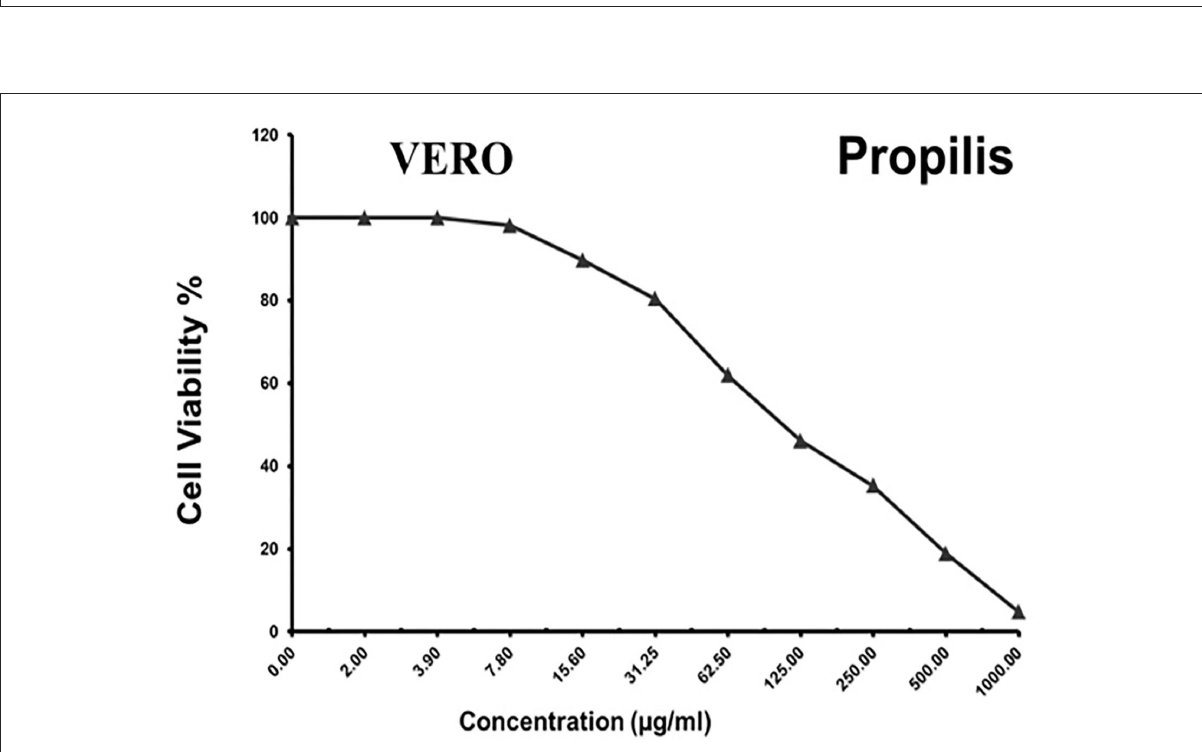
FIGURE4 Cytotoxic activity of propolis in mammalian cells derived from African Green Monkey kidney (Vero) cells at a 50% cell cytotoxic concentration (CC 50